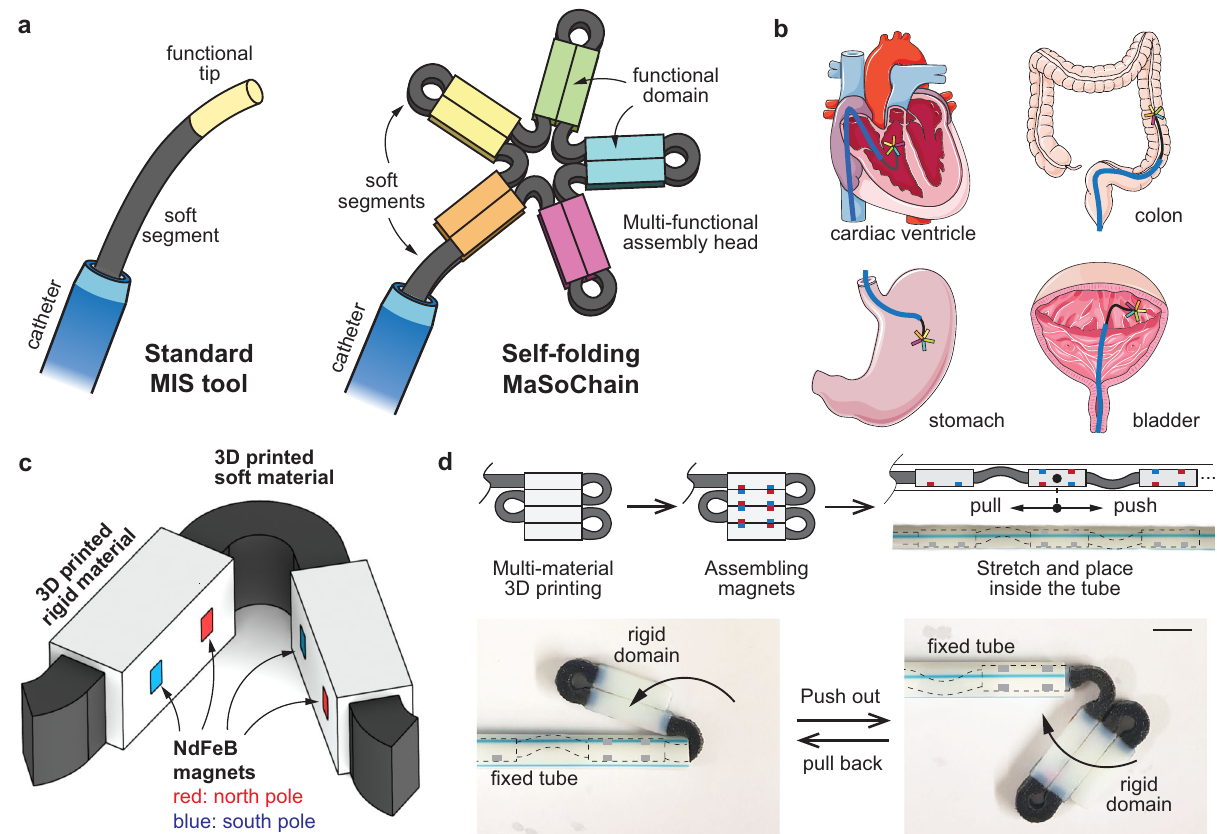
Fig. 1 | Concept and structure of magnetic soft-robotic chains (MaSoChains). a Aschematicillustrationof astandard MIStoolandaself-foldingMaSoChain. The MaSoChains can self-fold into large assemblies at the tip of the catheter with multiple functional domains. b Potential application scenarios for MaSoChains. When pushed out of the sheathing catheter (marked in blue), MaSoChain can fold into large functional structures (colored star) in relatively open chambers in the human body (e.g., heart ventricles, colon, stomach, bladder). c The basic self- folding unit of MaSoChains, composed of rigid segments (in white) connected by softsegments(inblack).SmallNdFeBmagnetsareembeddedatthesameheightas